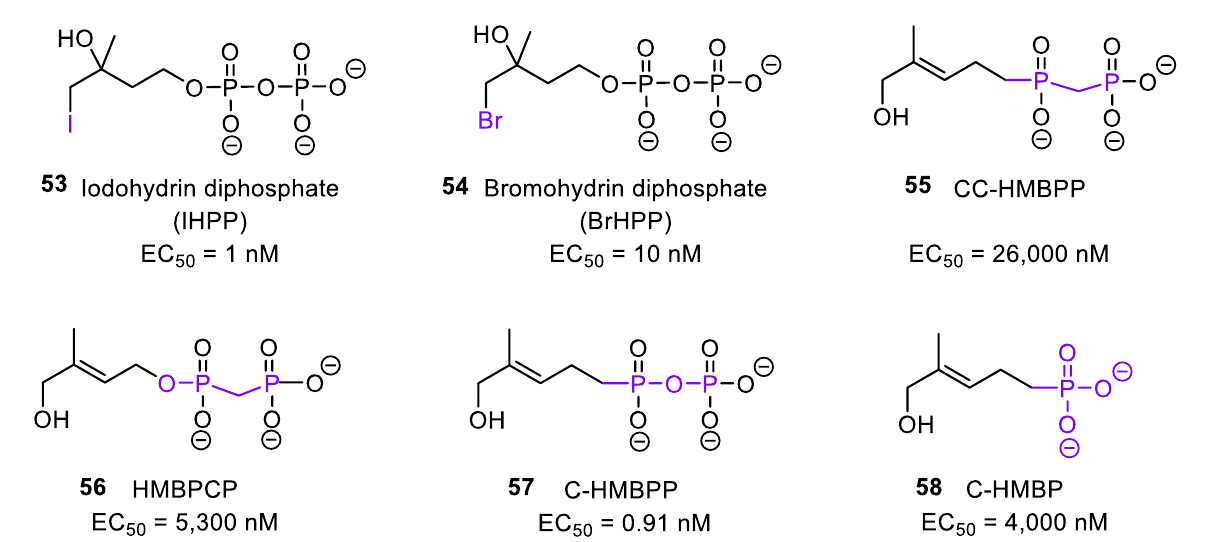
Figure 9. Synthetic phosphoantigens (PAgs).